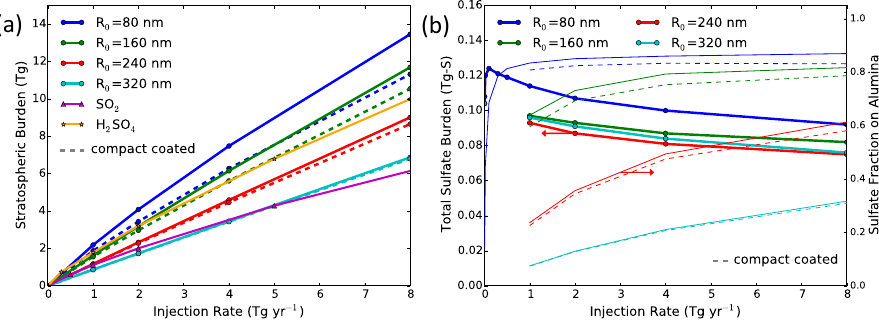
Figure 5. Annual average stratospheric burden of (a) alumina and (b) condensed sulfate versus injection rate for various sizes of injected alumina monomers. For comparison, we plot sulfate burden in Tg-S as a function of the rate of injection of SO 2 and H 2 SO 4 (Pierce et al., 2010) in Tg-Syr − 1 along with alumina burden in (a) . Panel (b) shows the fate of natural sulfate as a function of alumina injection rate, where the total sulfate burden is plotted on the left-hand axis (thick lines with circles) and the fraction of that burden that is on the alumina particles is shown on the right-hand axis (thin lines). The dashed lines represent simulations in which the coated alumina particles are assumed to become more compact in